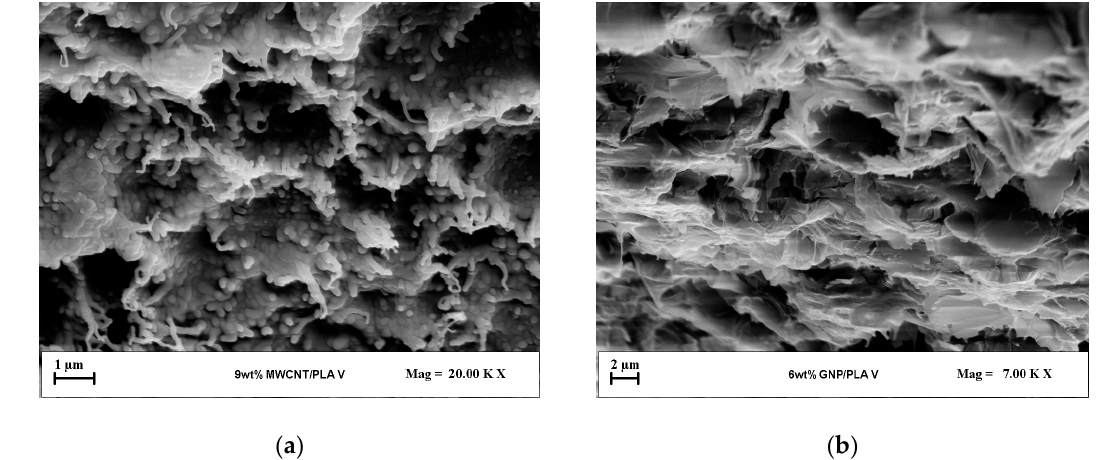
Figure 10. SEM micrographs of 9 wt% MWCNT/PLA (a) and 6 wt% GNP/PLA (b) nanocomposites.